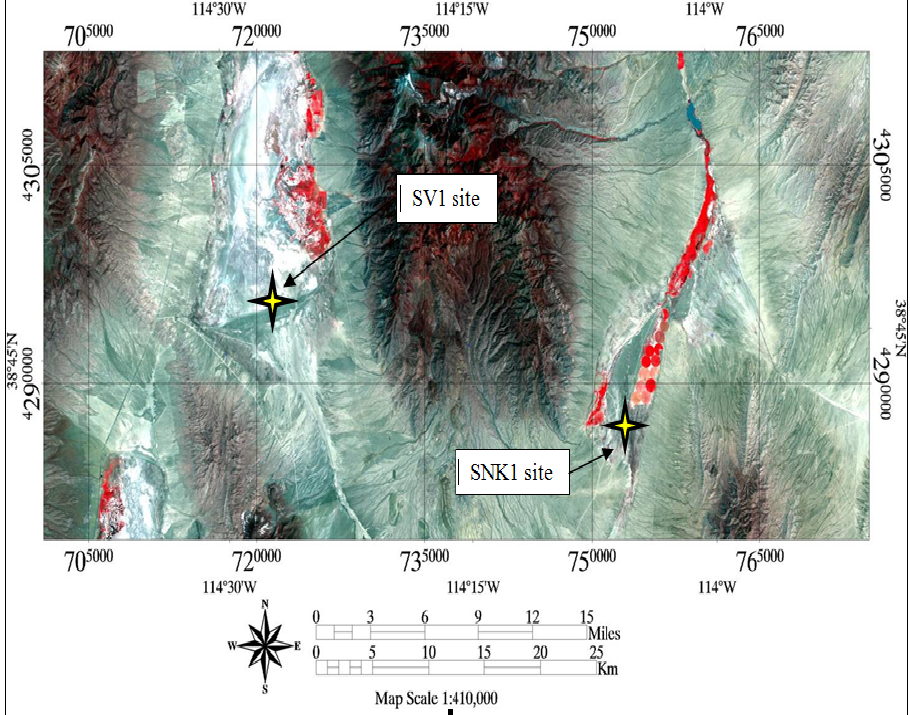
Figure 1. False color Landsat 5 TM image (2007) showing the location of the two study sites (Spring Valley 1 site and Snake Valley 1 site) in the Great